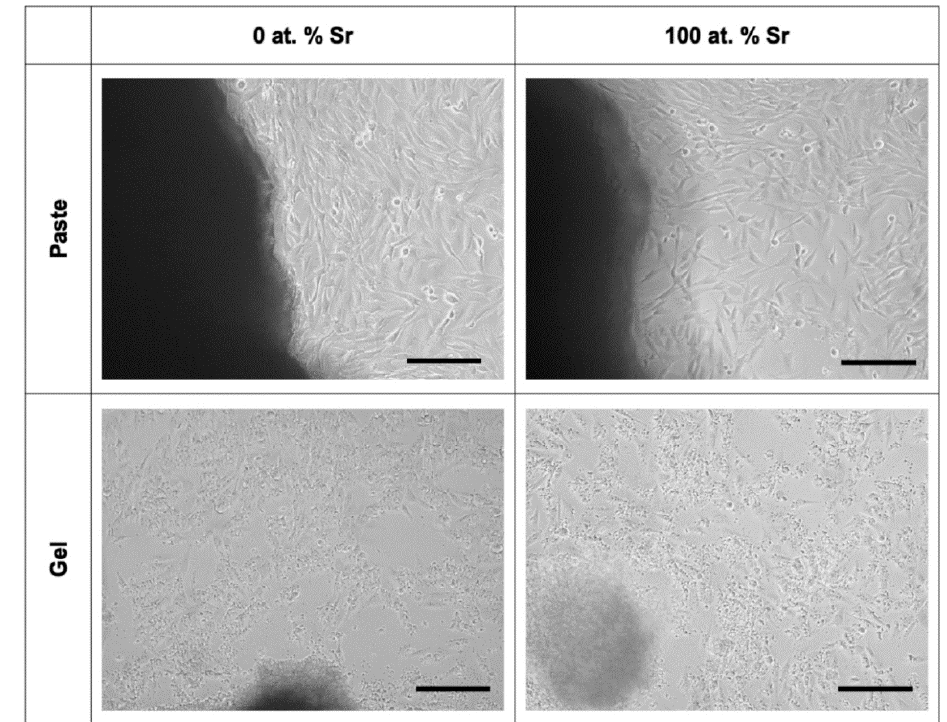
Figure 7. Light microscopy images for MG63 cells cultured directly with SrHA paste and gel (0 and 100 at.% Sr). Scale bar = 200 µm.